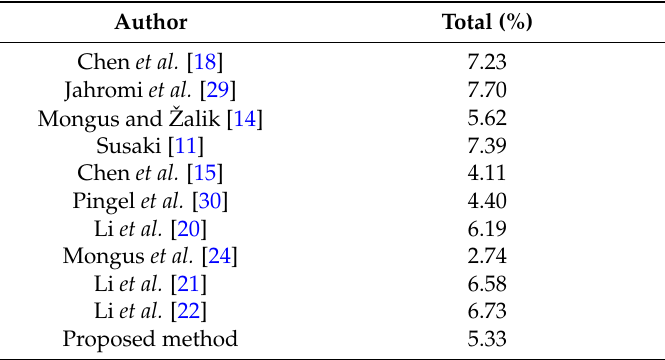
Figure 9. Comparison of the total error of different filtering algorithms for all samples. Table 3. Comparison of average total errors of the proposed method and other ten filtering algorithms proposed in recent years.